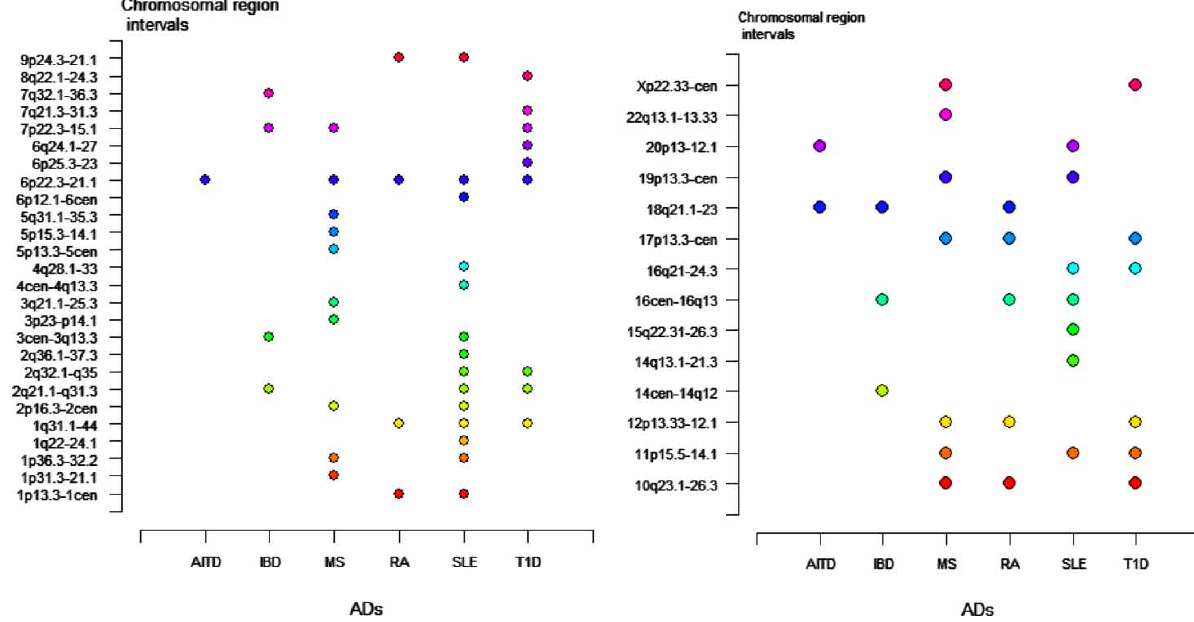
Figure 3. Chromosome regions overlap among ADs. The ordinate represents the AD, while the axis despites the chromosomal region intervals. This figure was generated from table III data. AITD: autoimmune thyroid diseases, IBD, inflammatory bowel disease; MS, multiple sclerosis; RA, rheumatoid arthritis; SLE, systemic lupus erythematosus; T1D, type 1 diabetes